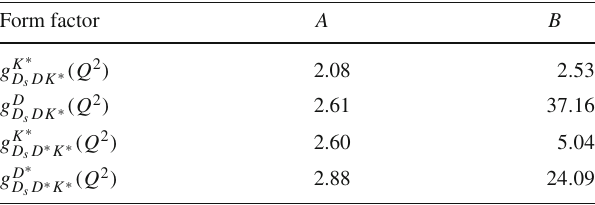
Fig. 8 Diagrams for the B → K ∗ π decay with D s , D ∗ intermediate s DK ∗ states